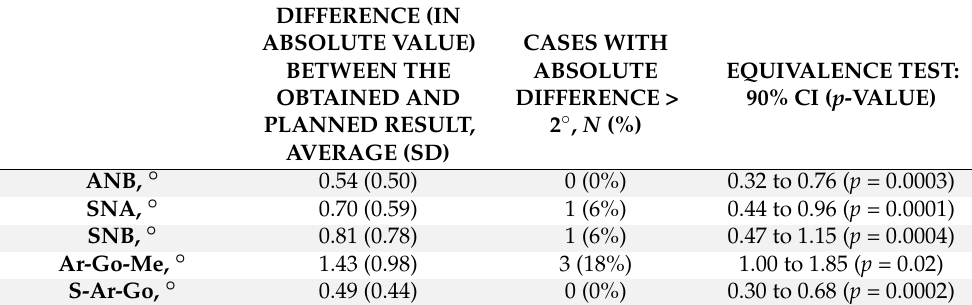
Table 3. Group B: non-syndromic skeletal class III